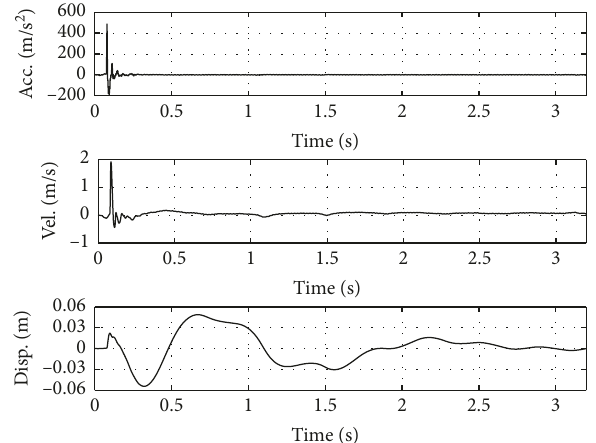
Figure 8: The corrected shock acceleration signal and its integrations.